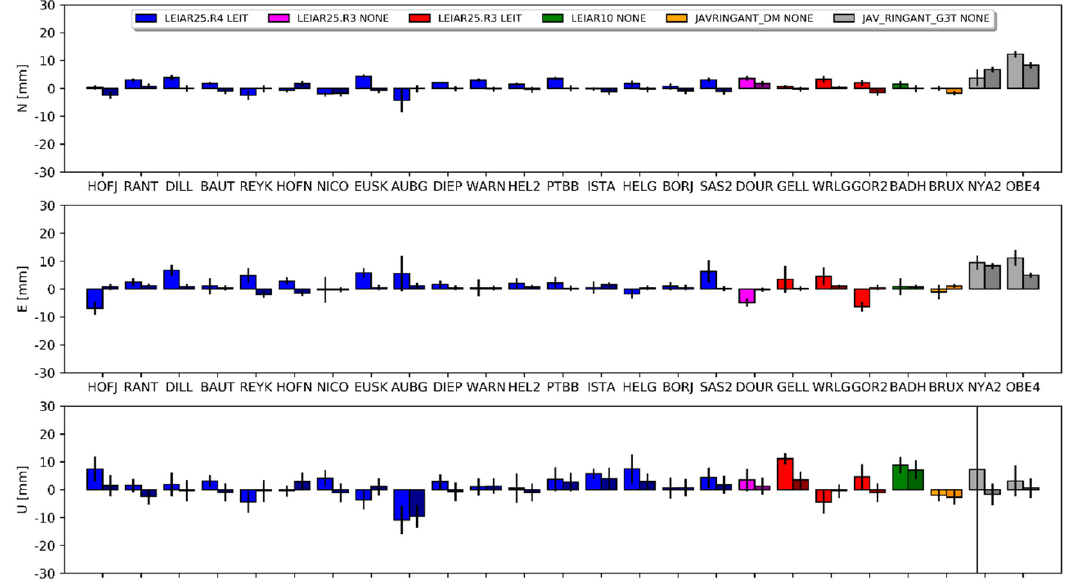
Figure 9. Coordinate differences between the E3 and G2 solutions and their standard deviations. Darker columns refer to the DD approach. Values are presented in Table A5.